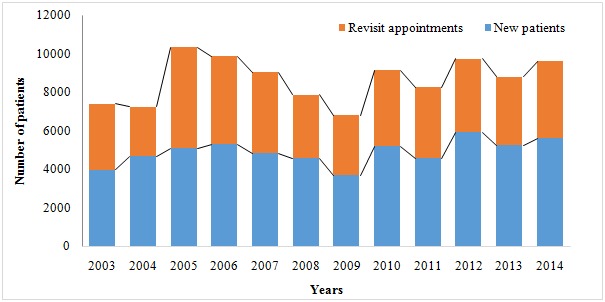
Graph 1: Distribution of new and revisit appointments during 2003-2014 time period.